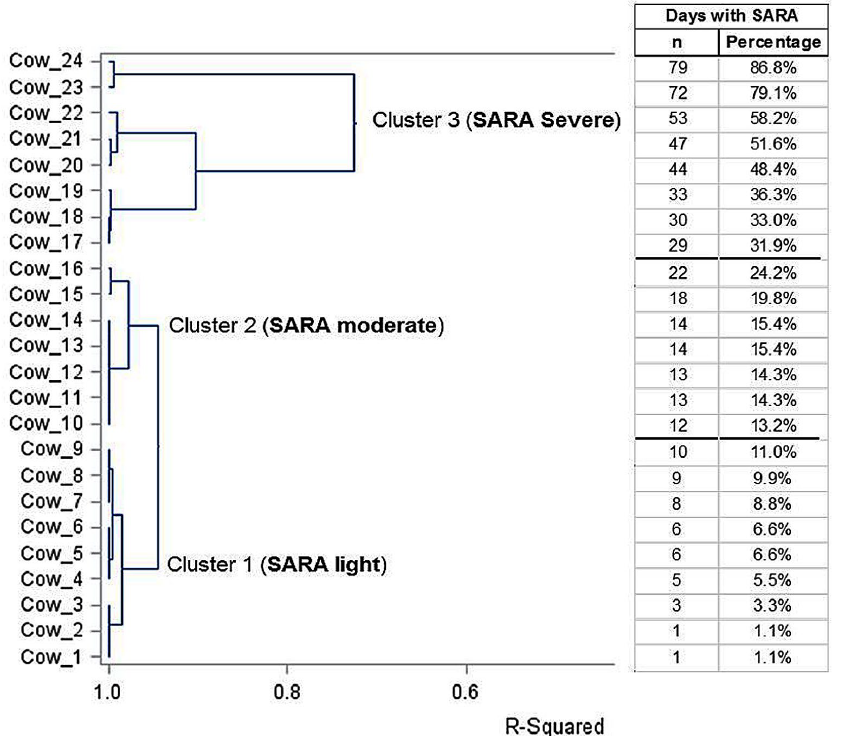
Figure 1. Results of the cluster analysis with the dendrogram and R 2 of 24 Holstein cows clustered into three groups of SARA severity (light, moderate and severe) and the data of single cows regard- ing days experiencing SARA (as numbers or percentage of the days with SARA). days experiencing SARA (as numbers or percentage of the days with